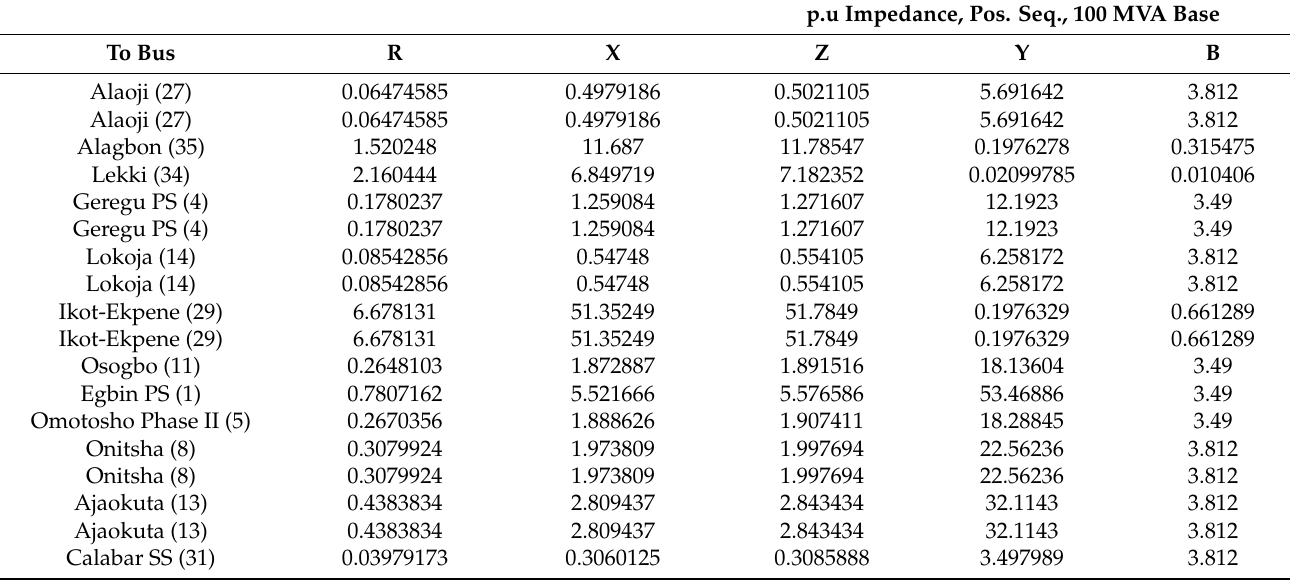
Table 8. The 41 bus Nigerian network parameters